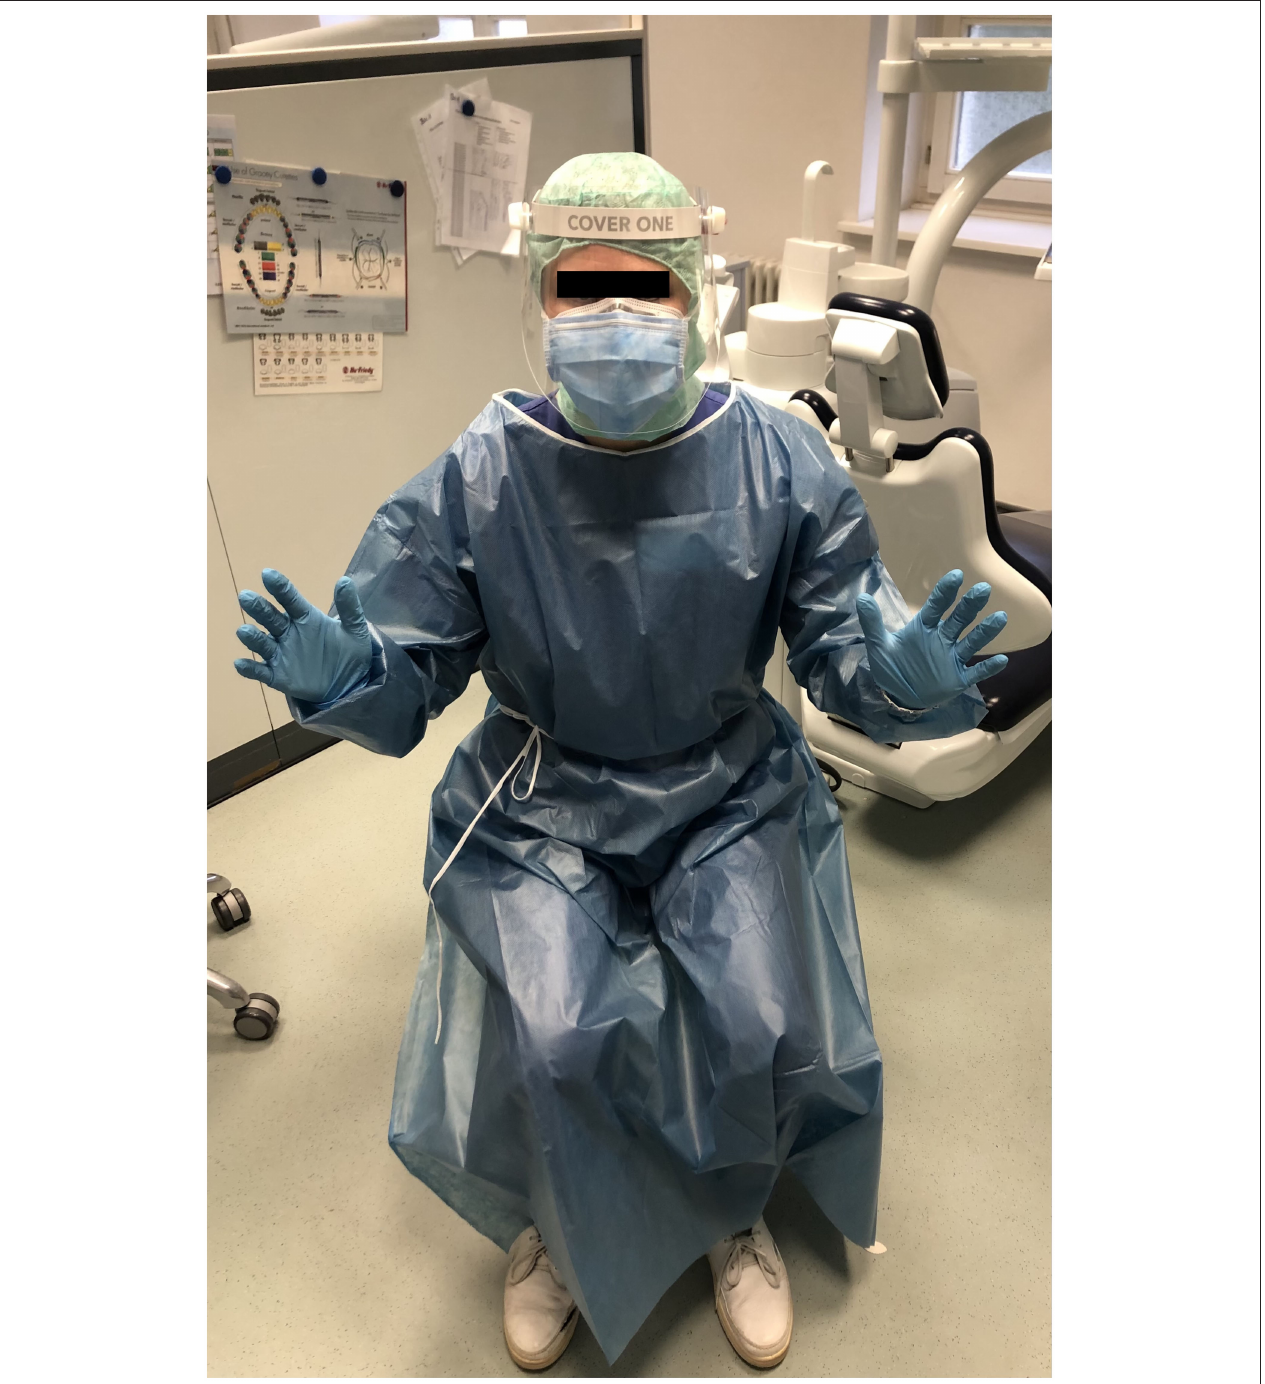
FIGURE 1 | Personal protective equipment: surgeons hood, surgical mask (type 2, 3 layers), (magnification glasses), face shield, protective gown, examination gloves. Underneath the surgical face mask, a FFP-2 mask was placed.